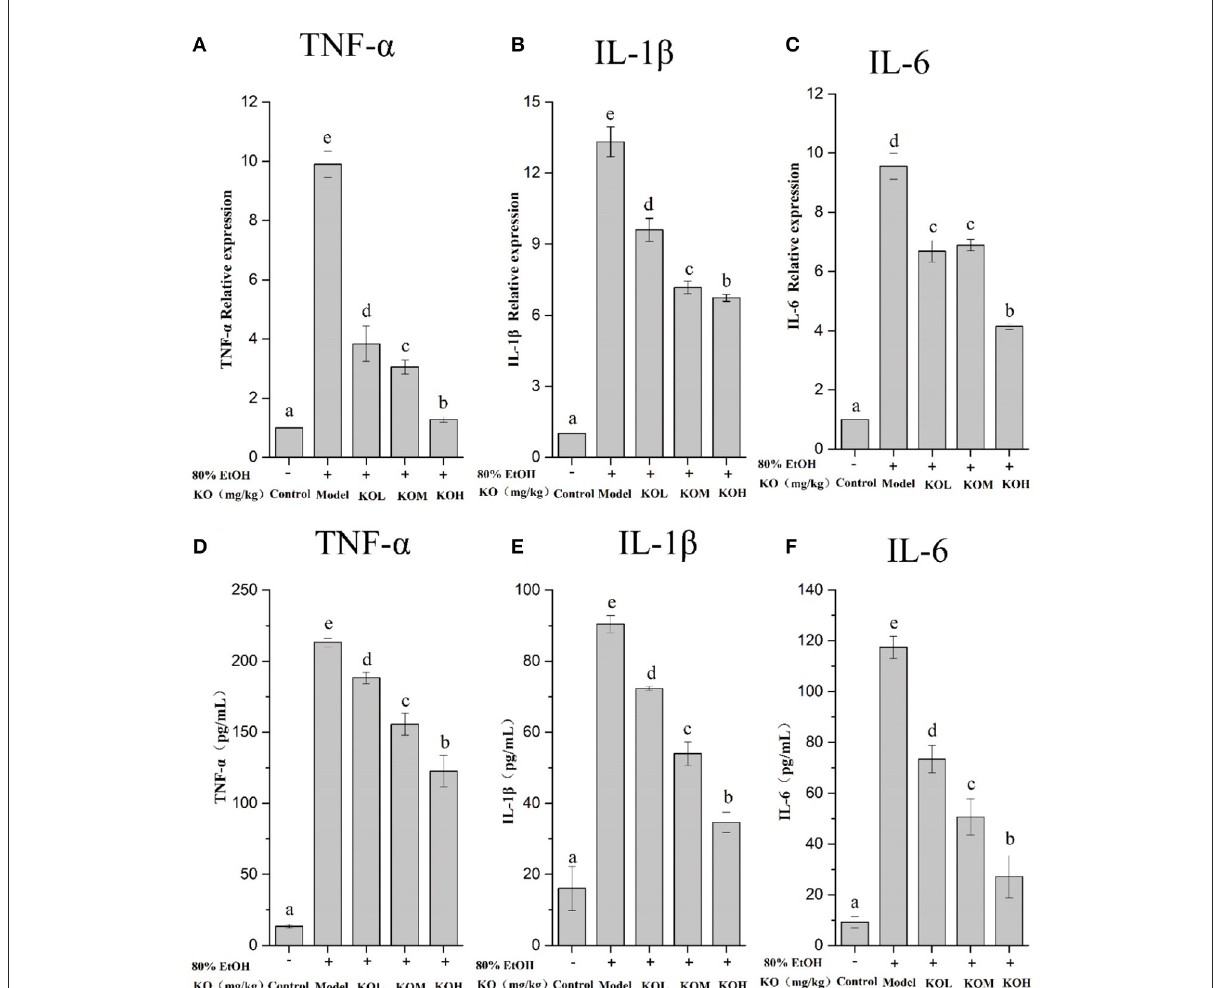
FIGURE4 The expression of inflammatory factors was analyzed using qPCR (A–C) and the relative expression of inflammatory factors in tissues was detected using ELISA (D–F) . Different letter values ( n = 6; mean ± SEM) indicate statistically significant differences from the same column model group ( p < 0.05 ). KOL, krill oil of 100 mg/kg; KOM, krill oil of 200 mg/kg; KOH, krill oil of 500